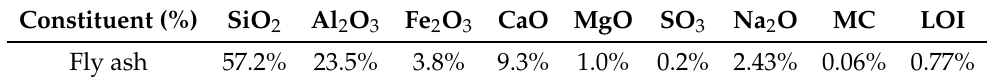
Table 3. Chemical composition of fly ash [37].